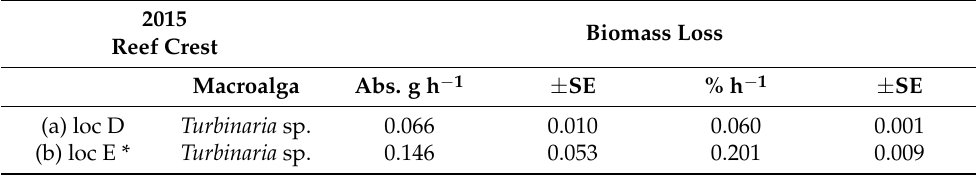
Table 4. Biomass loss of macroalgae in single-choice assays in a local reef (loc D) (a) and in the marine park (loc E) (b) on the reef crest in 2015. Given are absolute biomass loss in g h − 1 ± SE as well as biomass loss in % h − 1 ± SE per algae genus. Locations with significant biomass loss are marked with *.